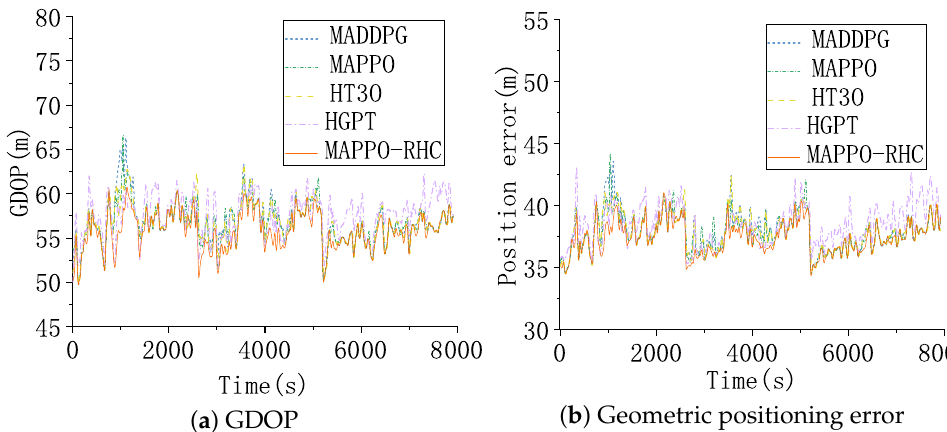
Figure 15. GDOP and geometric positioning